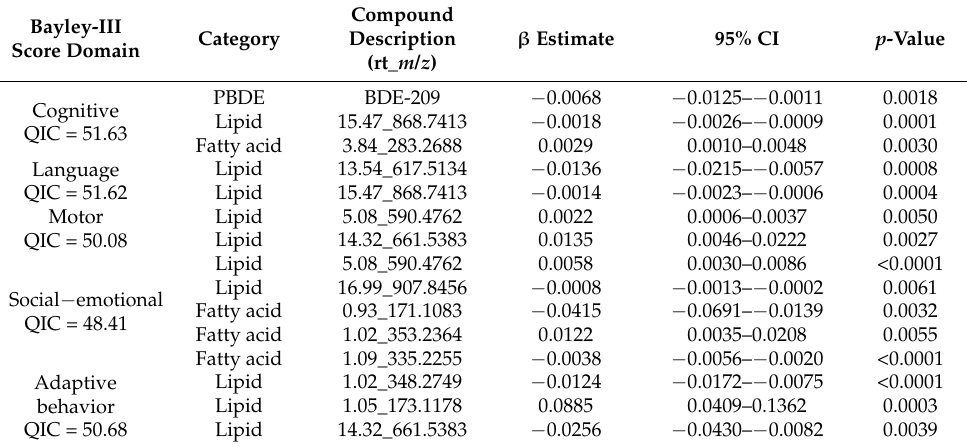
Table 5. Multivariate analyses between PBDEs, lipids, and fatty acids combined and the five domains of the Bayley-III developmental score (n = 100) adjusted for mother’s age, mother’s education, family income, mother’s smoking during pregnancy, prepregnant BMI, parity number of birth, living period in Kaoping area, newborn’s sex, gestational age (weeks), birth weight, birth length, and head